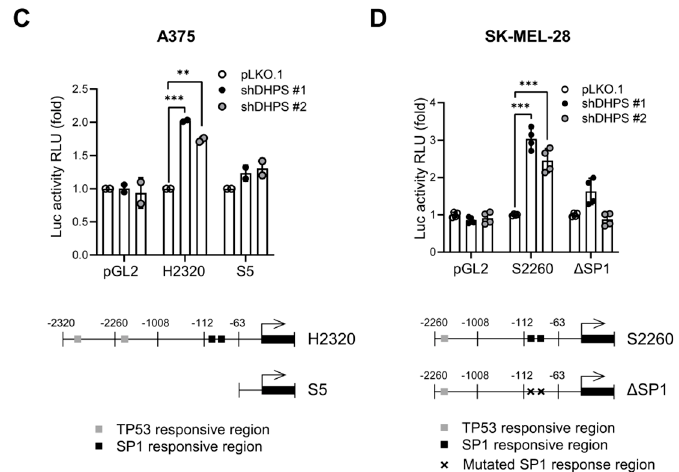
Figure 6. DHPS depletion increases CDKN1A transcription via TP53 and SP1 in BRAF V600E tumor cells. ( A ) (top) qPCR analysis of total RNA of cells infected with pLKO.1-shDHPS for 5 days. (bottom) RT-PCR analysis of the same total RNA samples. β -actin was the control for RNA amounts. ( B ) Western blots of total lysates of cells co-infected for 5 days with pLKO.1-shDHPS virus and pLKO.1-shSP1 viruses expressing shRNA targeting different regions of SP1 mRNA (shSP1 #1 and shSP1 #2, top panel) or with pLKO.1-shDHPS virus and pLKO.1-TP53 viruses expressing shRNA targeting different regions of TP53 mRNA (shTP53 #1 and shTP53 #2, bottom panel). ( C , D )